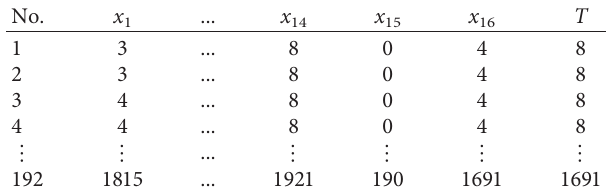
Table 2: The dataset in this